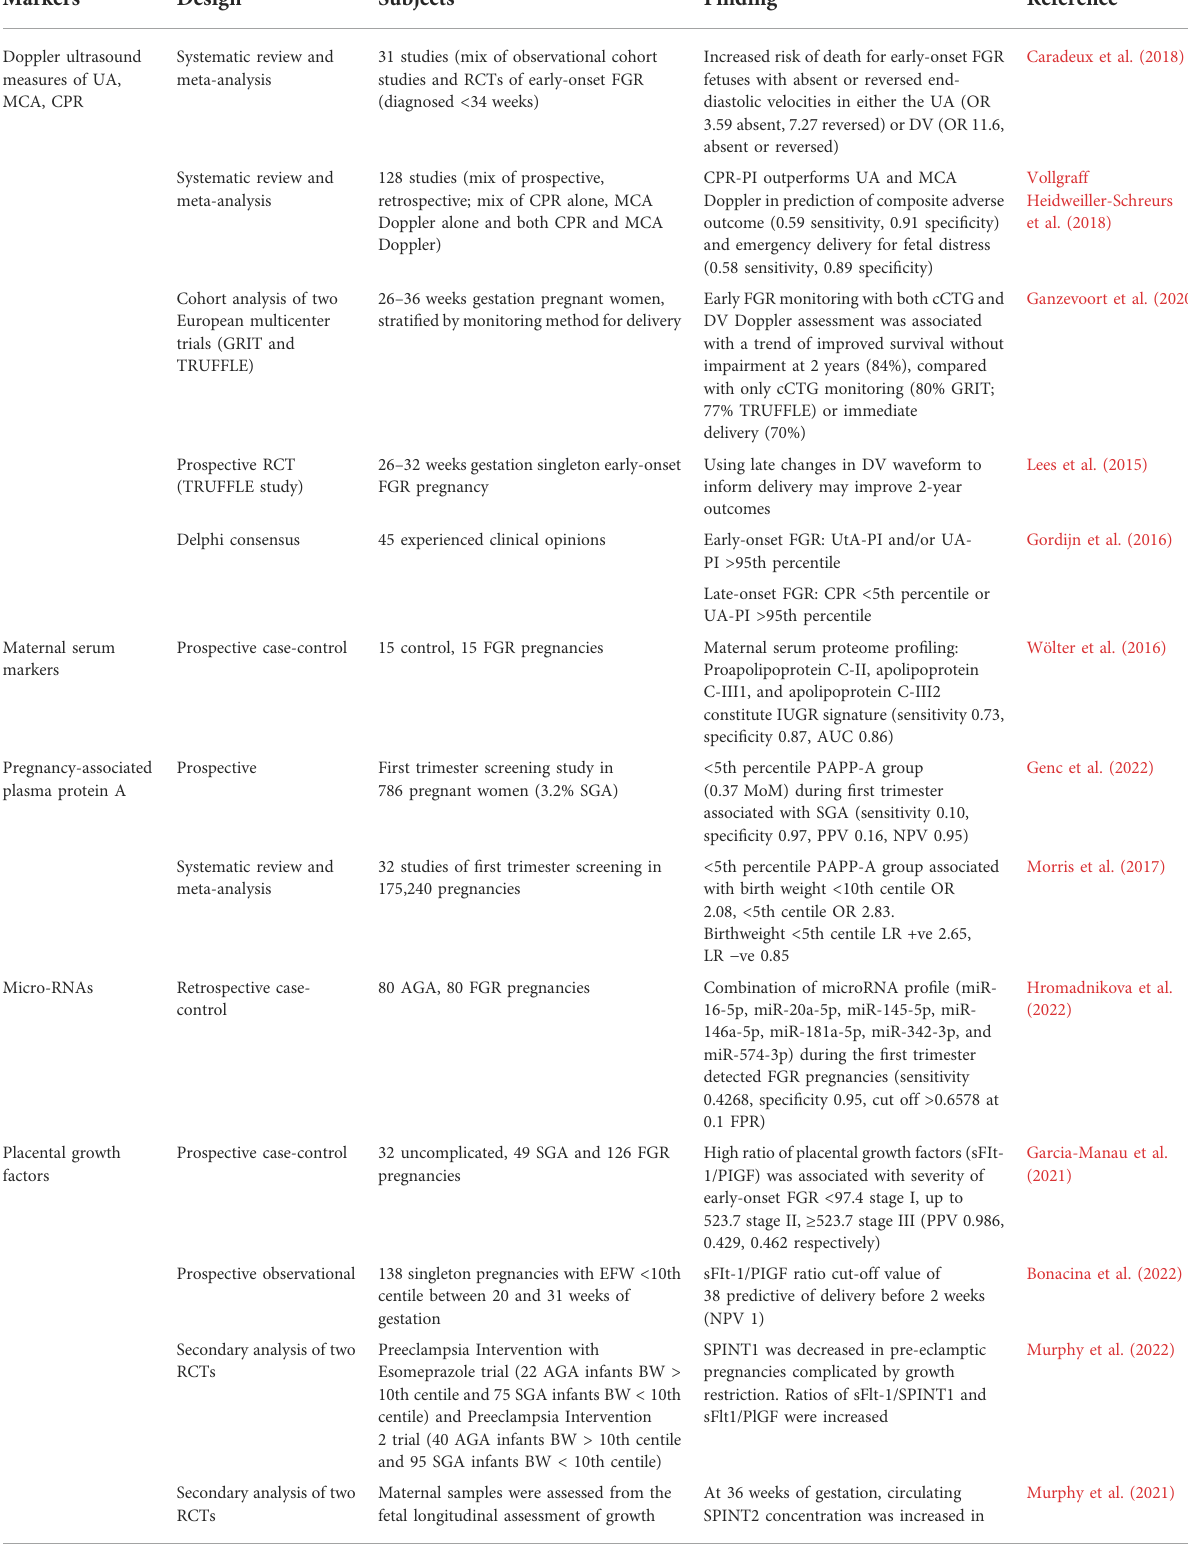
TABLE 1 Summary of select studies of potential biochemical and physiological markers of